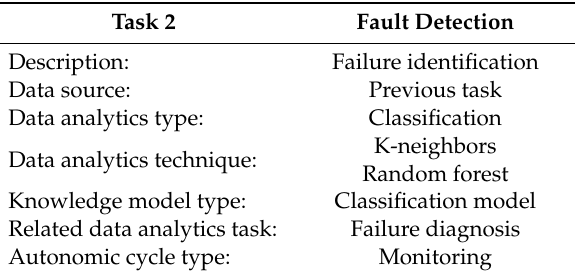
Table 3. Description of Task 2 for fault detection.